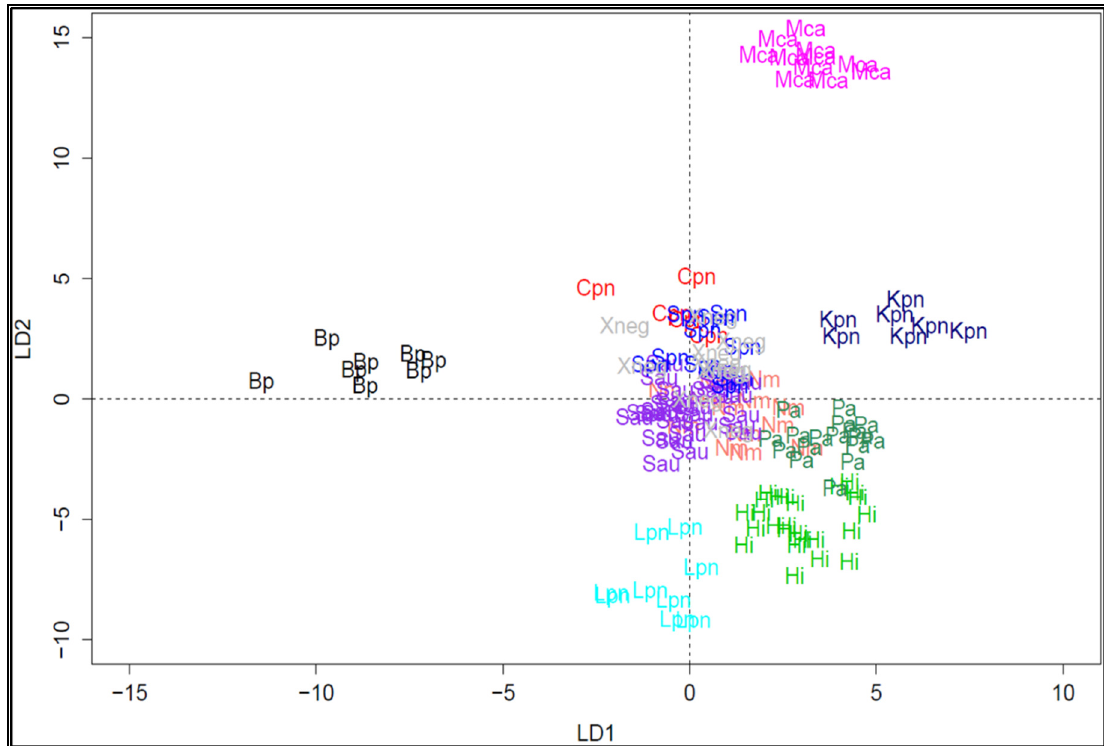
Figure 3. Two-dimensional projection of the hybridization profiles for 166 samples using canonical discriminant analysis. The samples that have been used to generate the training set are a combination of pure bacterial strains and clinical specimens in which bacterial species have been also identified by microbiological method. Bp, Bordetella pertussis ; Cpn, Chlamydiae pneumoniae ; Hi, Haemophilus influenzae ; Lpn, Legionella pneumophila ; Kpn, Klebsiella pneumoniae ; Mca, Moraxella catharralis ; Spn, Streptococcus pneumoniae ; Nm, Neisseria meningitidis ; Sau, Staphylococcus aureus ; Pa, Pseudomonas aeruginosa .